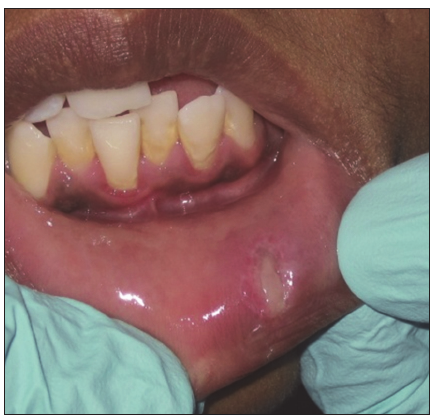
Figure 10: Photograph showing postoperative view: Day 8.